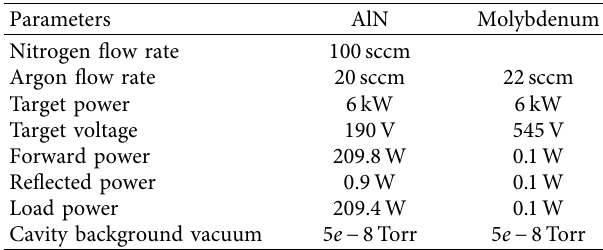
Table 1: Te growth parameters comparison between AlN and Mo in sputtering process.